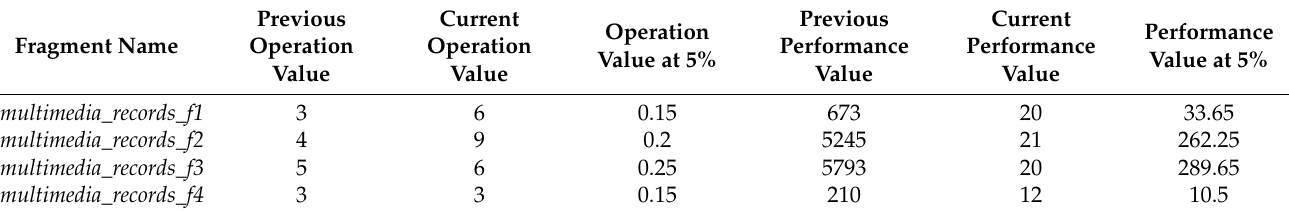
Table 7. Threshold analysis in dynamic fragmentation.